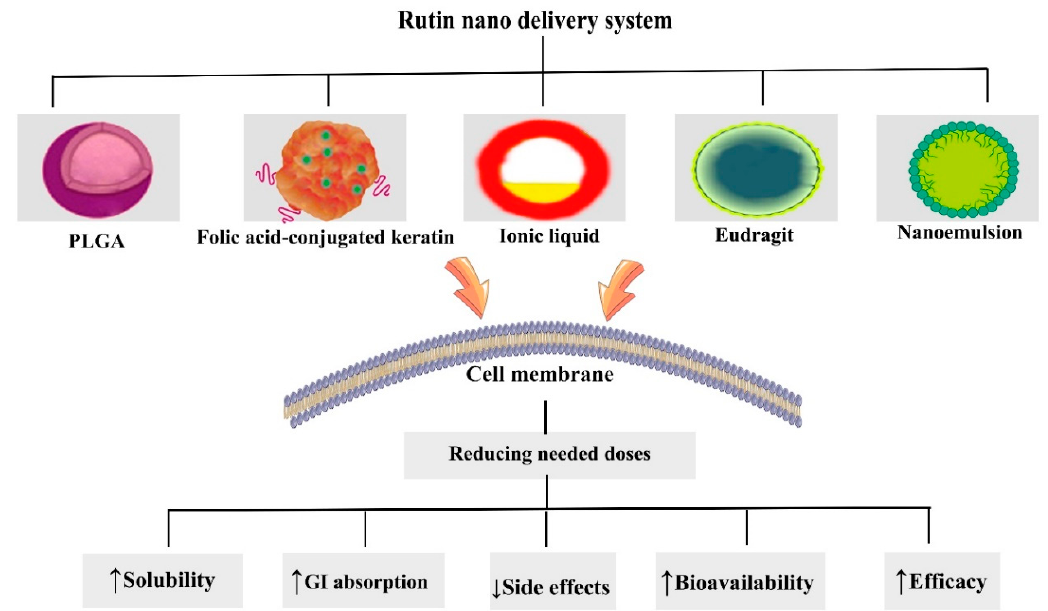
Figure 3. Nanoformulations of rutin used to combat cancer. GI, gastrointestinal; PLGA, poly (lactic co-glycolic acid).